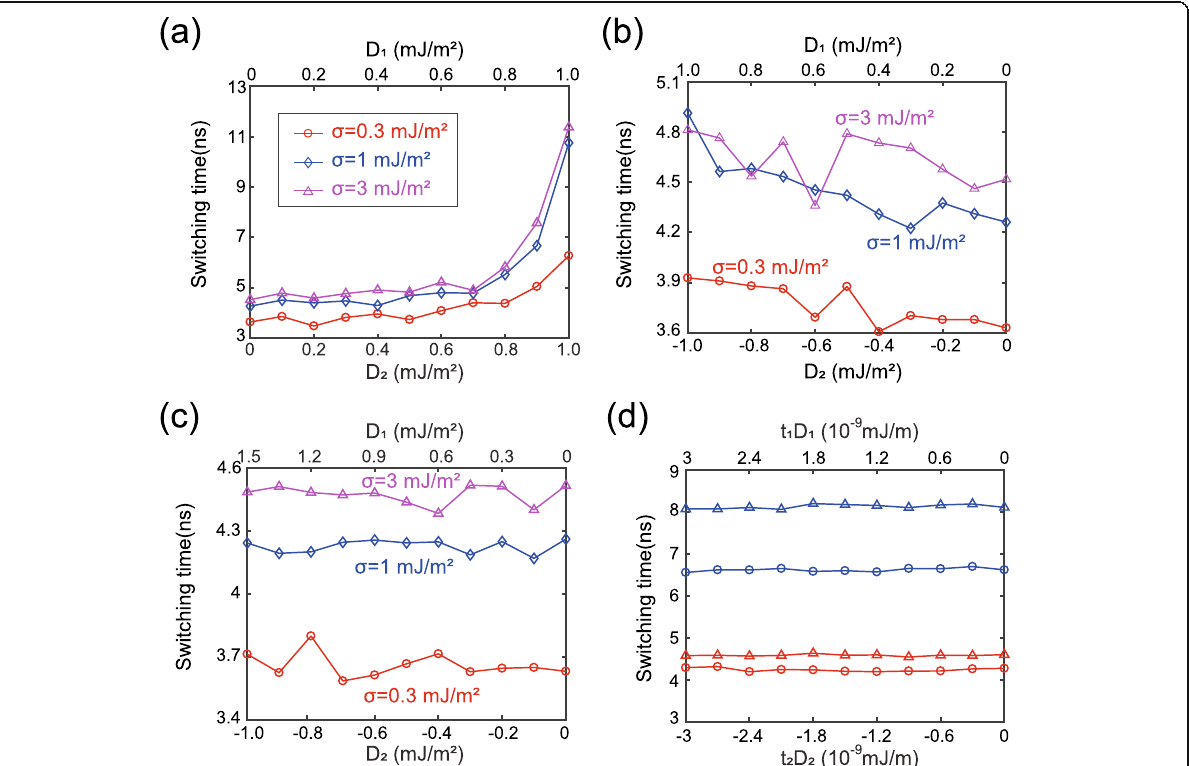
Fig. 3 Switching time as a function of DMI strength. a D 1 and D 2 are set to the same positive value. b D 1 and D 2 are set to the same value, but with the opposite signs. c D 1 and D 2 are configured to meet t 1 D 1 + t 2 D 2 = 0. d Additional results while changing the thickness or anisotropy constant, meanwhile keeping